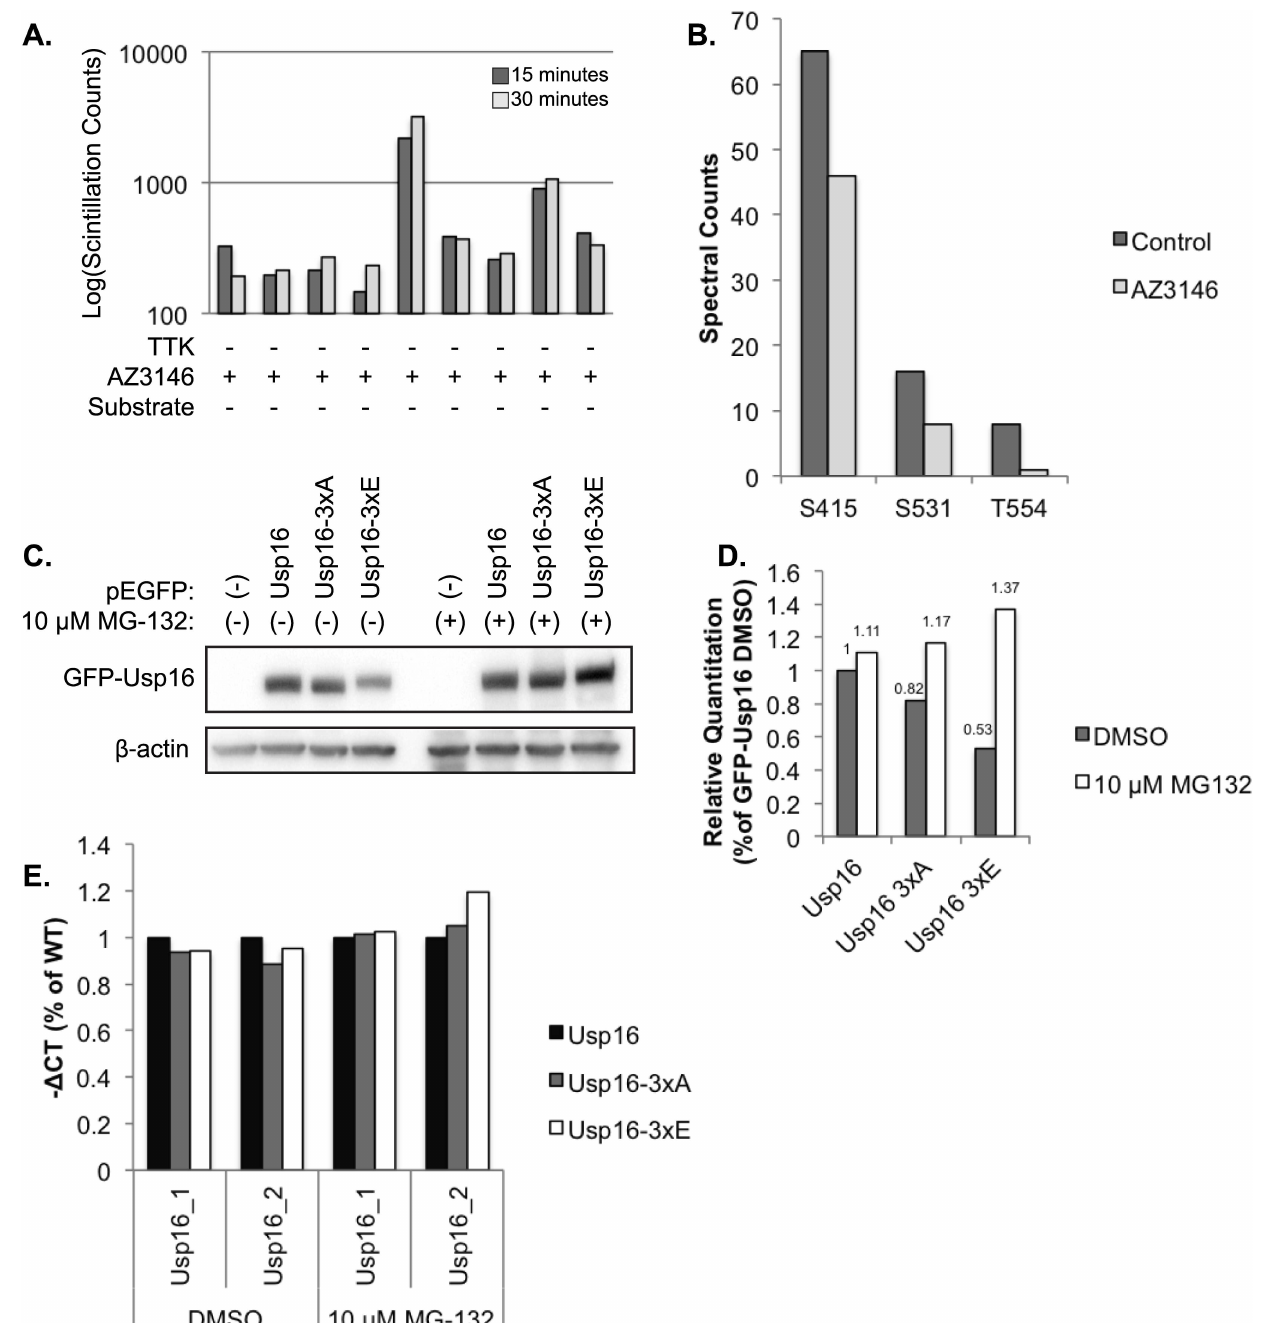
Fig 5. Usp16 is a TTK phosphorylation substrate. (A) In vitro kinase assay measuringTTK dependentphosphorylation by 32 P incorporation measuredby liquidscintillation counts. Representative of 2 independentexperiments. (B) Exogenously expressed FLAG-Usp16 was immunoprecipitatedfrom DMSO and AZ3146 treated mitotic 293FT cells, digested with trypsin and enrichedfor phosphopeptides. Phosphorylated residues of Usp16 were identifiedby mass spectrometry. Spectral counts of representative individualexperiments are shown. (C) Immunoblotanalysisof 293FT cells transiently transfected with control GFP, GFP-Usp16, GFP-Usp16 3xA (phosphodeficientmutant) or GFP-Usp16 3xE (phosphomimetic mutant) and treated with control DMSO or MG-132. (D) Densitometry of (C). (E) RT-PCR of Usp16 using 2 independentTaqman probesfrom cells used in (C), normalized to β -actinand representedas percent of WT-Usp16.